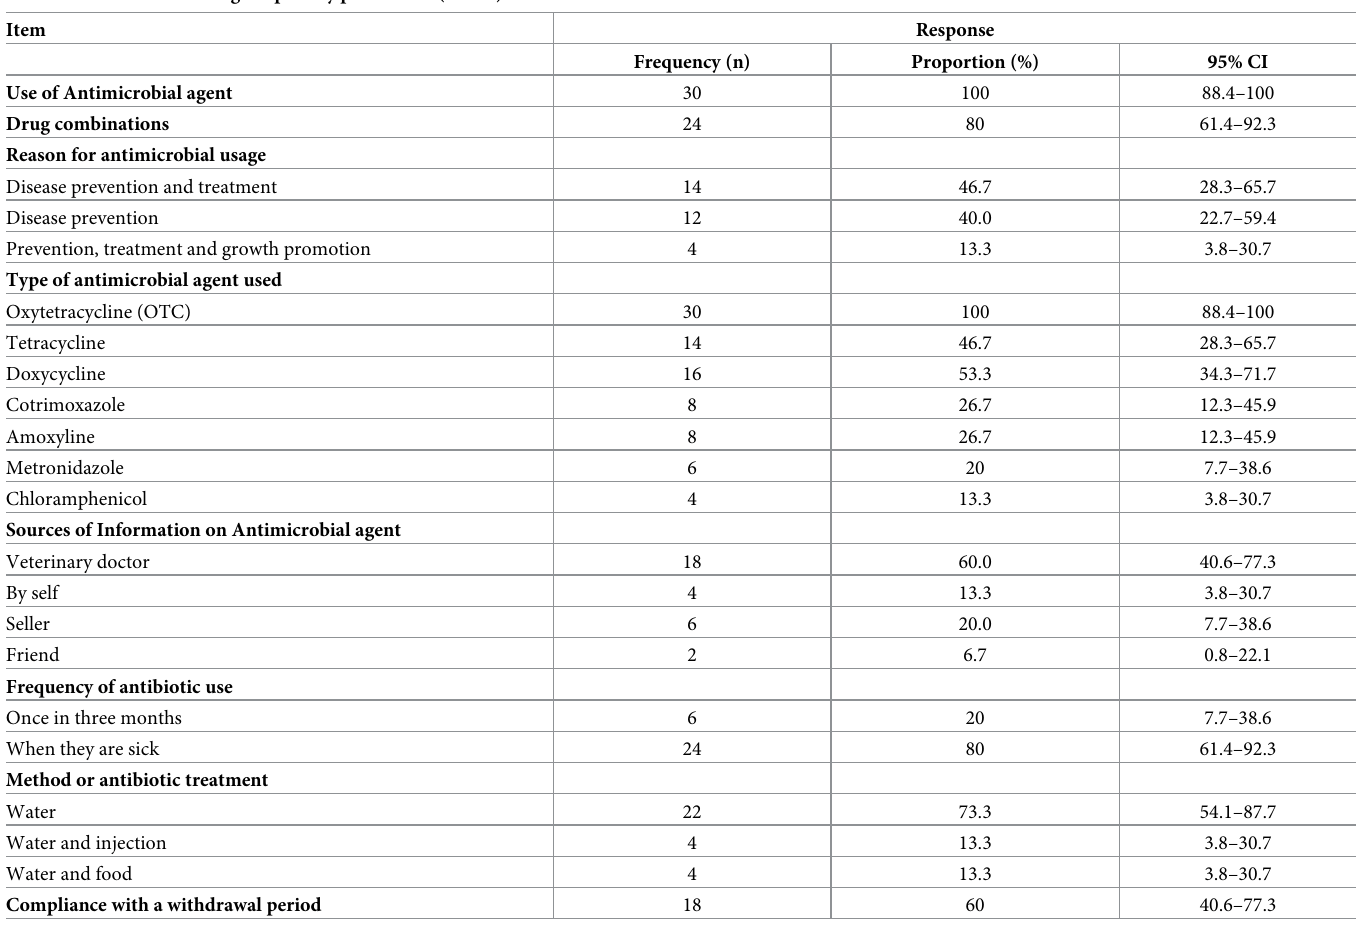
Table 6. Antimicrobial usage in poultry production (n =